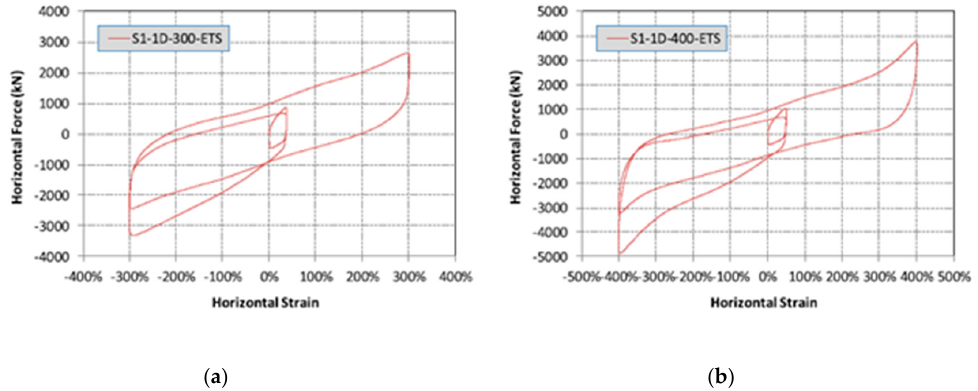
Figure 3. Strain-force curves in the unidirectional sinusoidal test [13]: ( a ) 300% Strain; ( b ) 400% Strain.